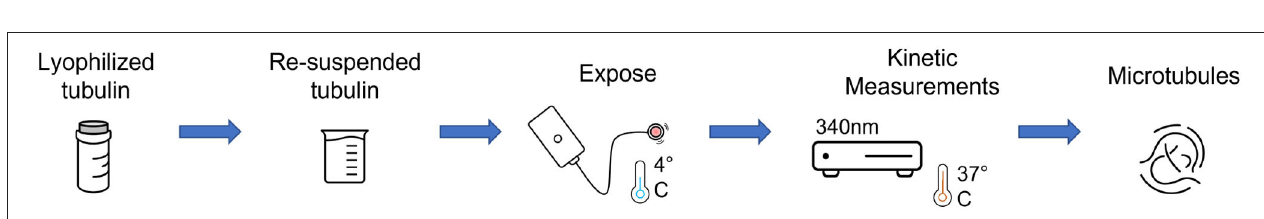
and exposed turbidity measurements, respectively. These values were overlayed onto the turbidity curves, as shown in Figure 10